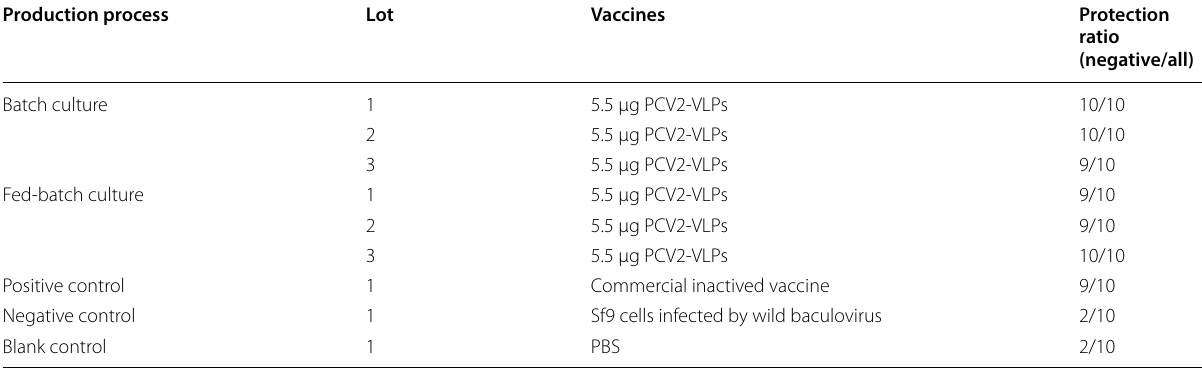
Table 2 The protection ratio of the subunit vaccine prepared by the PCV2-VLPs produced in different processes for the PCV2 virus infection in mice Production